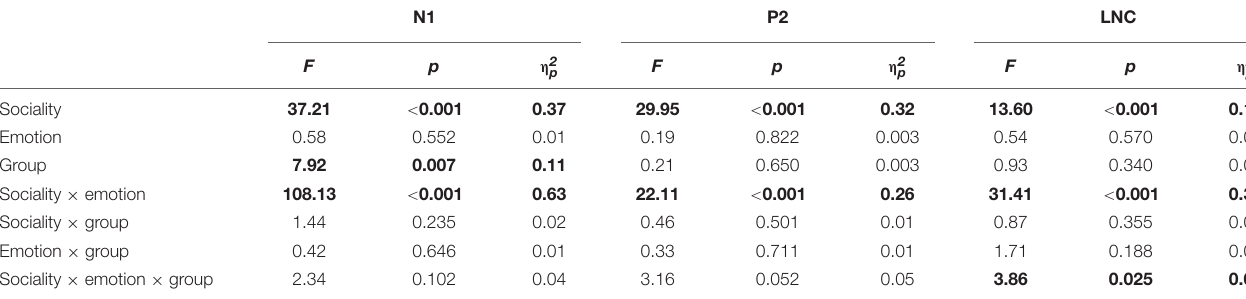
TABLE 4 | Summary of statistical analyses of ERP amplitudes in Experiment